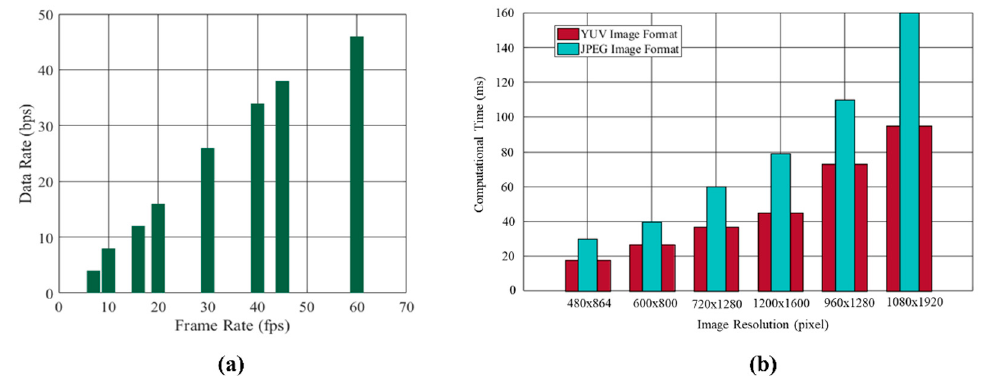
Figure 11. ( a ) Data rate vs. camera frame rate; ( b ) image processing performance vs. image sensor resolution. Table 2. Receiver parameters configuration.